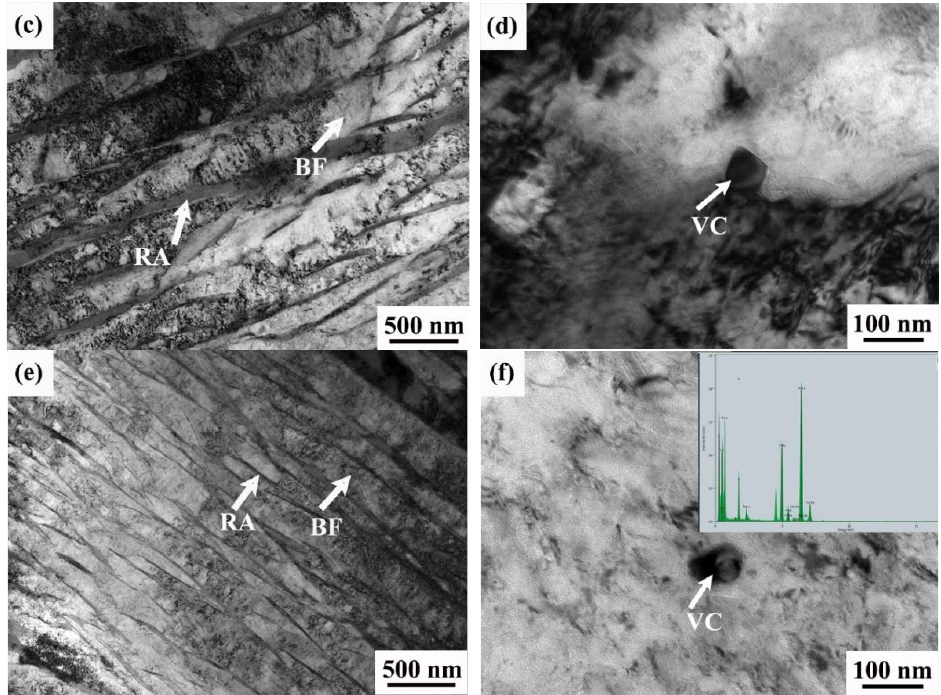
Figure 8. TEM micrographs of specimens with different heat treatment processes. ( a , b ) 950 °C; ( c , d ) 950 °C – 870 °C; and ( e , f ) 950 °C – 848 °C.